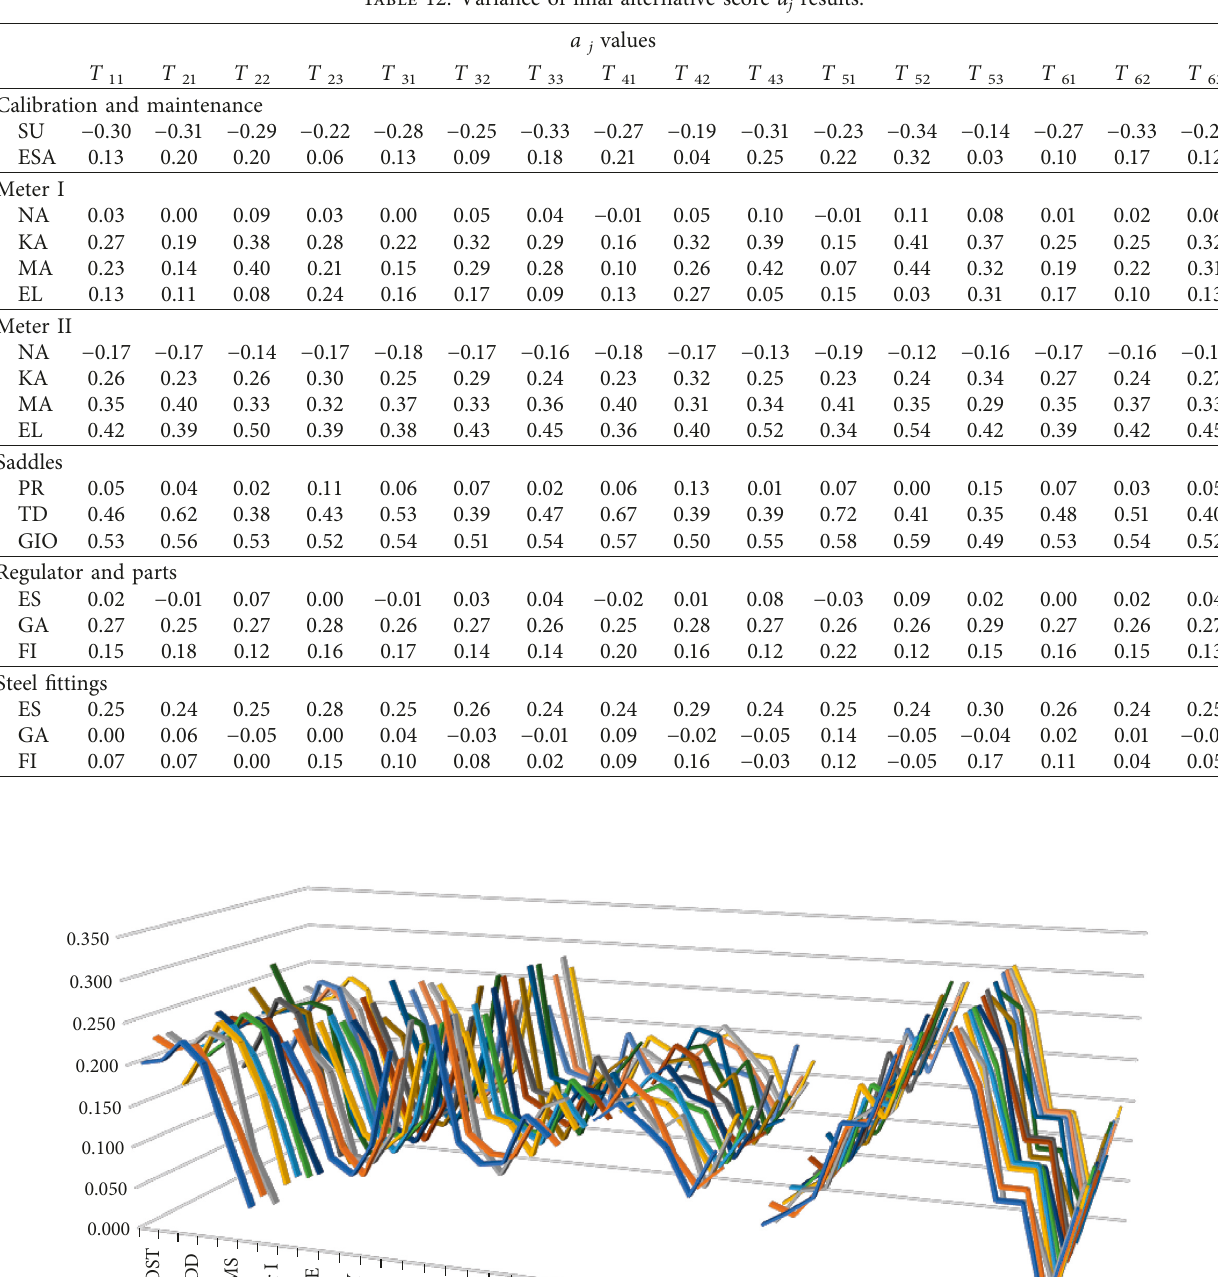
Table 12: Variance of final alternative score a